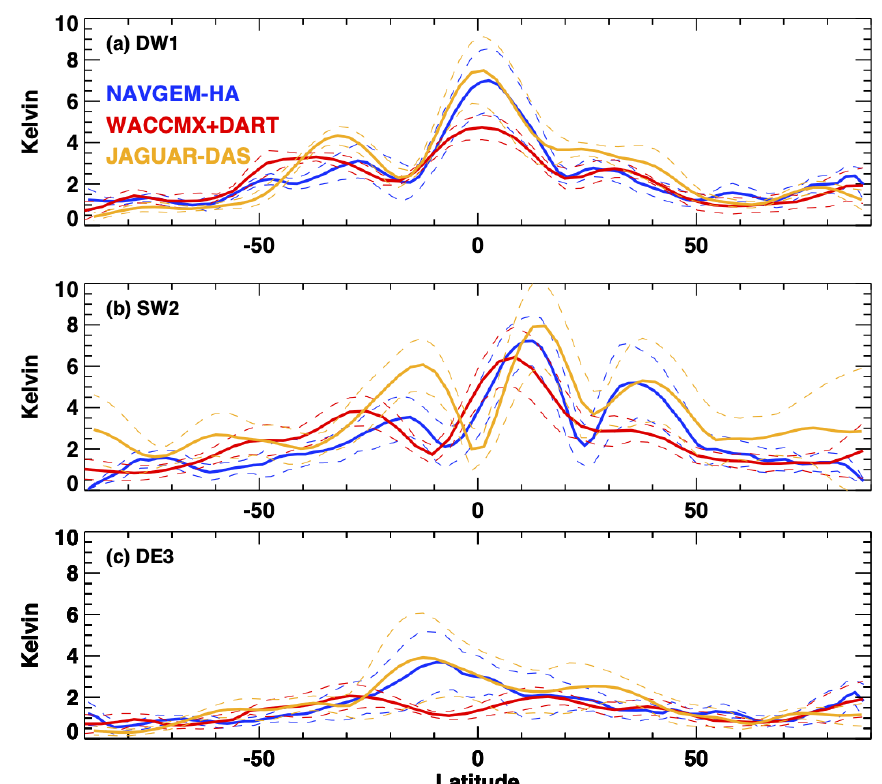
Figure 21. Latitude dependence of the mean amplitude and ± 1 standard deviation values for (a) migrating diurnal wave 1 (DW1), (b) migrating semidiurnal wave 2 (SW2), and (c) nonmigrating diurnal wave 3 (DE3) at 90km altitude obtained from NAVGEM-HA, WACCMX + DART, and JAGUAR-DAS from 27 January to 9 February from Figs.